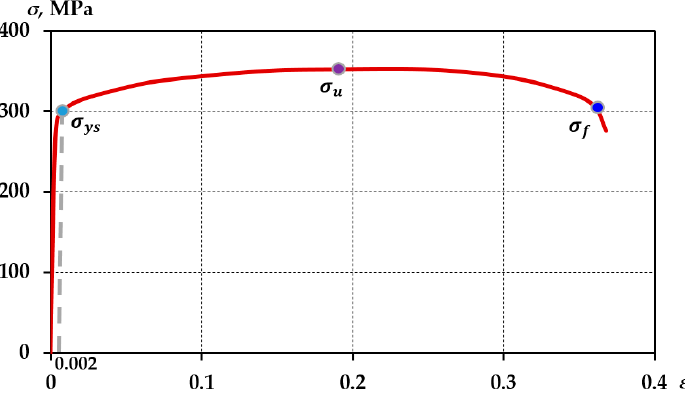
Figure 2. Single uniaxial tensile deformation diagram of steel M2O.